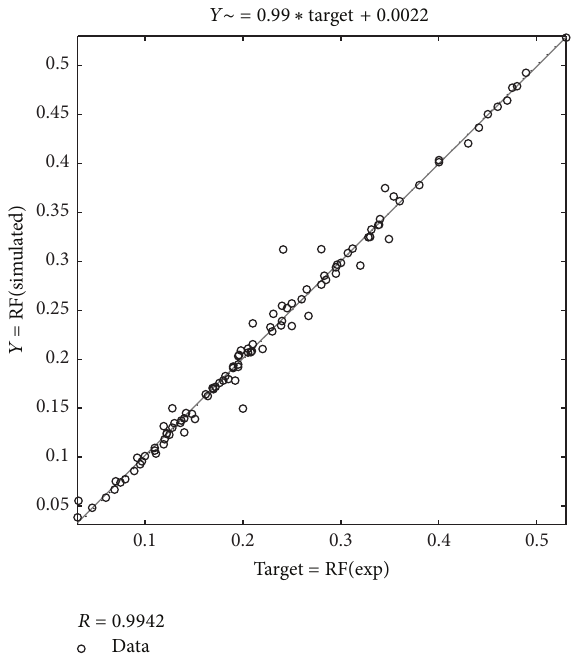
Figure 2: The relation between ANN predictions and actual experimental data.